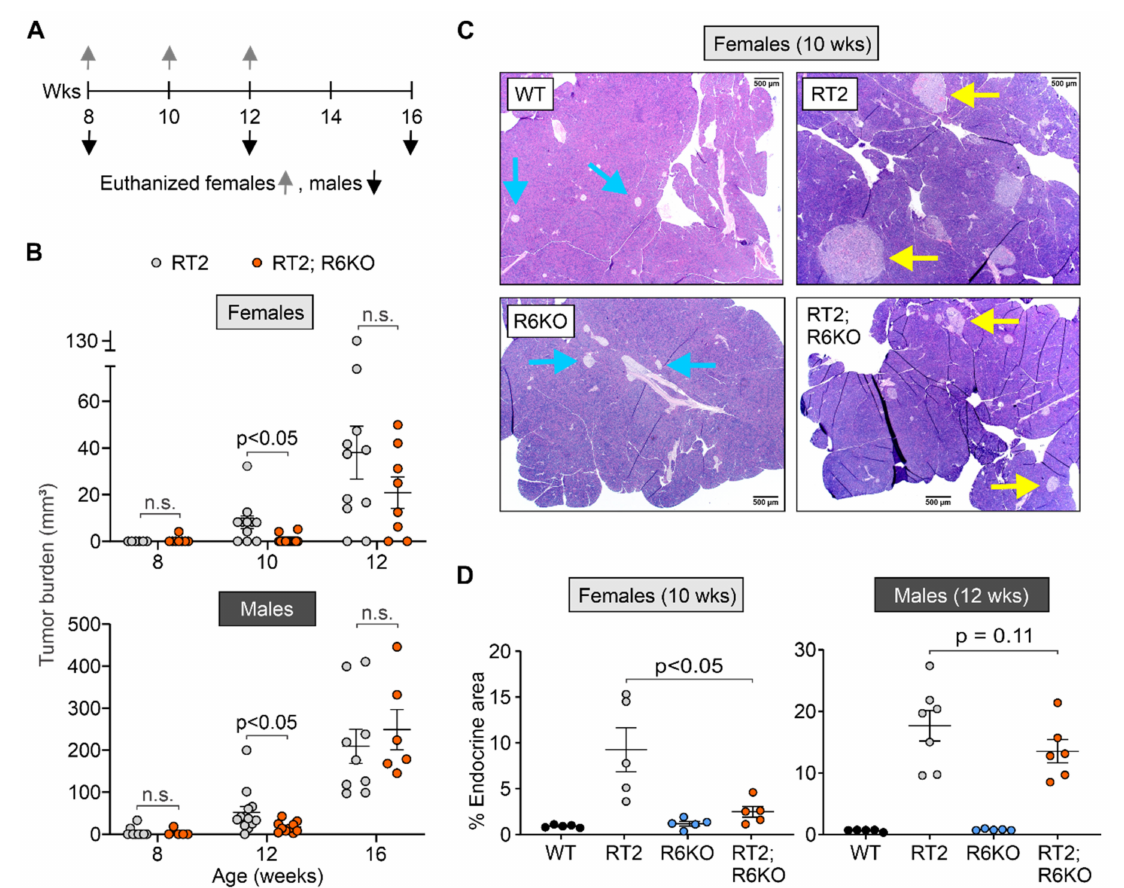
Figure 3. Loss of RABL6A delays tumor formation in RT2 mice. ( A ) Study timeline showing ages in weeks (wks) of female (up arrow) and male (down arrow) mice when they were euthanized for islet isolation or histopathology of the pancreas. ( B ) Tumor burden is significantly reduced in 10-week-old female and 12-week-old male RT2; R6KO mice (orange) compared to age-matched RT2 controls (gray). P values shown; n.s., not significant. N = Females: 8 weeks (RT2 = 6, RT2; R6KO = 8), 10 weeks (RT2 = 11, RT2; R6KO = 14), 12 weeks (RT2 = 11, RT2; R6KO = 8); Males: 8 weeks (RT2 = 9, RT2; R6KO = 5), 12 weeks (RT2 = 13, RT2; R6KO = 11), 16 weeks (RT2 = 9, RT2; R6KO = 6). ( C ) Representative images of H&E-stained pancreas from 10-week-old WT, RT2, R6KO, and RT2; R6KO females. Blue arrows, normal islets; yellow arrows, transformed islets. Scale bar = 500 µ M. ( D ) Reduction in the % endocrine area in 10-week-old RT2: R6KO females (left, p < 0.05) with similar trend ( p = 0.11) in 12-week-old RT2; R6KO males (right) versus RT2 controls. Data in A, B, and D represent the mean +/ − SEM with each individual animal represented by a dot. N = Females (WT = 5, RT2 = 5, R6KO = 5, RT2; R6KO = 5); Males (WT = 5, RT2 = 7, R6KO = 5, RT2; R6KO = 6). Linear regression models were used to evaluate differences in tumor burden and beta regression models to compare percent endocrine